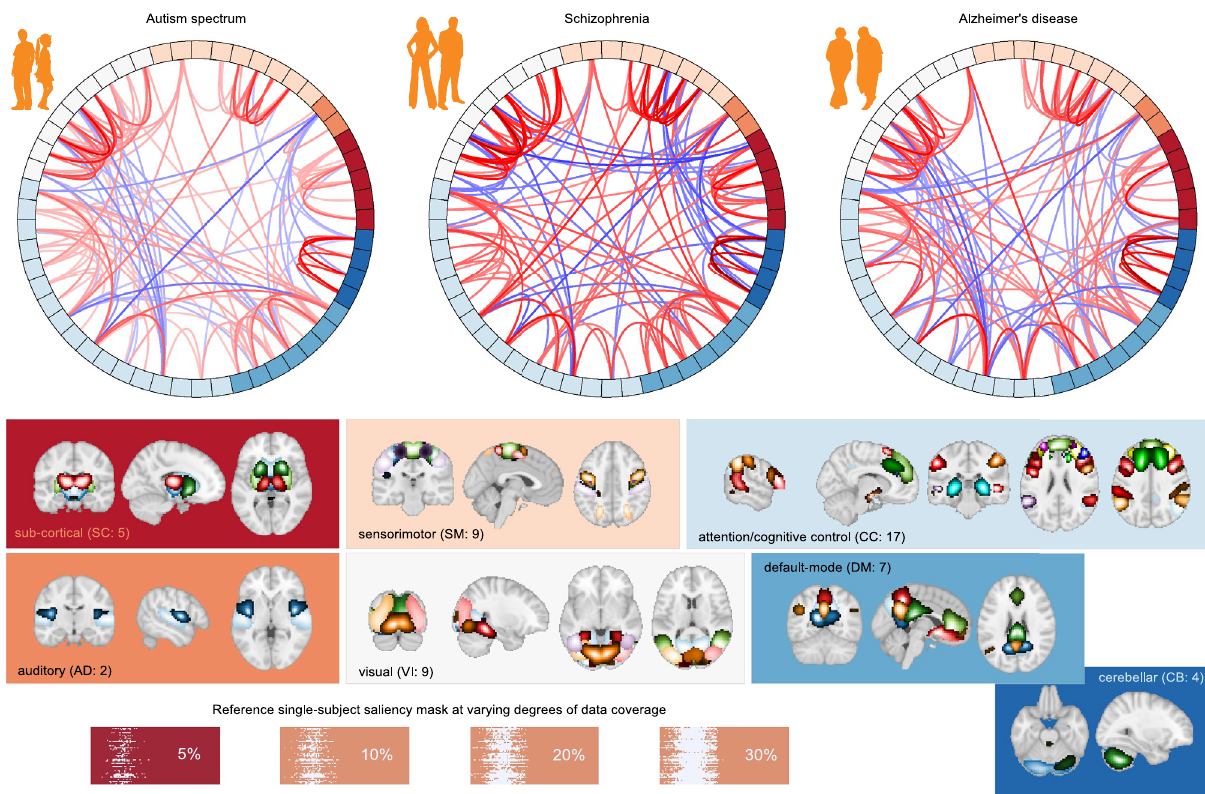
Figure 4. Top 10% FNC for patients computed using most 5% of the salient data as thresholded using feature attribution maps (saliency maps) for different disorders (created in programs MNE 1.1.dev0, https:// mne. tools/ dev/ and Inkscape 1.1.2, http:// inksc ape. org/ relea se/ inksc ape-1. 1.2). Apart from the high predictive capacity of the salient data, we observed some intriguing differences among these connectograms. The autism spectrum disorder exhibits the lowest between-domain FNC. However, salient data in autism disorder highlights domain changes in specific cerebellum, sensorimotor, and subcortical domains. The model-identified salient data reflects the most widespread pattern for schizophrenia and is consistent with the literature showing cerebellum interaction across multiple domains and sensorimotor changes. The predictive features for Alzheimer’s disease mainly concentrate on visual and cognitive